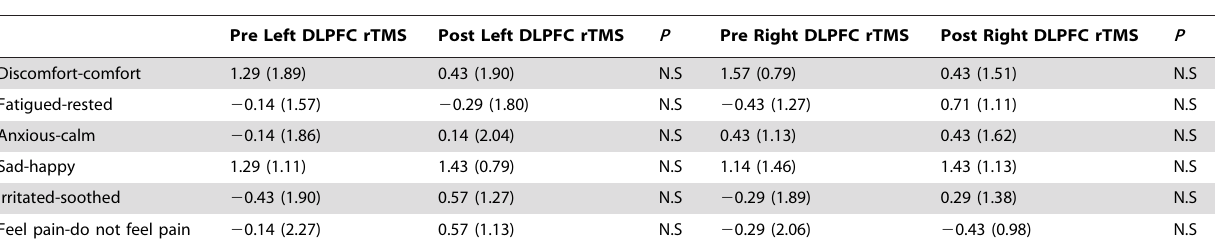
Table 3. Mean behavioral ratings before and after rTMS of the left and right